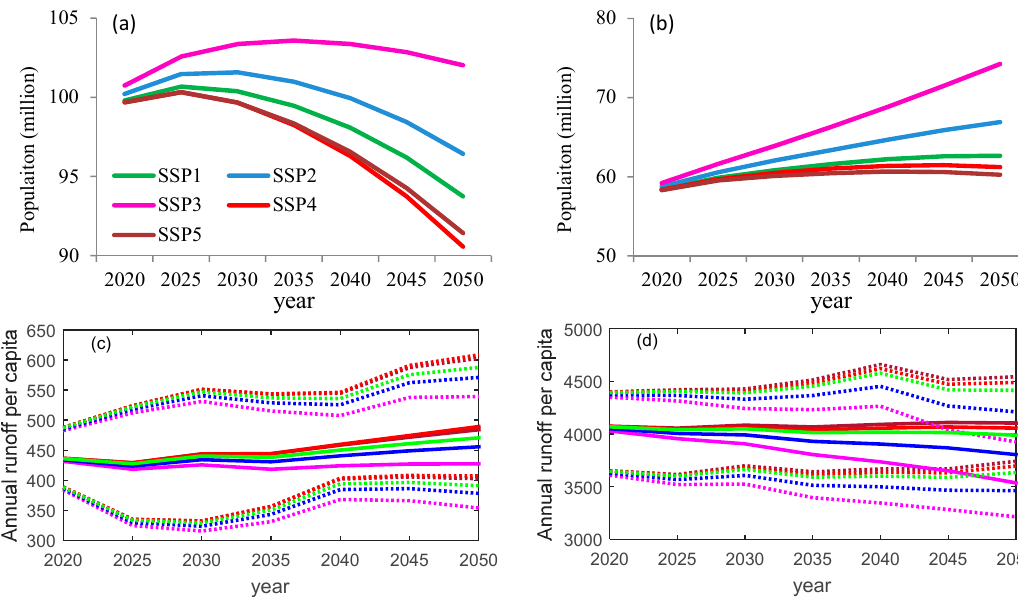
Figure 7. Population in ( a ) the Yellow River Basin and ( b ) the Xijiang River Basin. Mean and 90% confidence bounds of water stress under the five SSPs in ( c ) the Yellow River Basin and ( d ) the Xijiang River Basin. Green, blue, pink, red, and brown lines represent SSP1, SSP2, SSP3, SSP4, and SSP5 respectively. Solid lines indicate SSP mean and dashed lines represent the 90% confidence bounds under each SSP scenario.